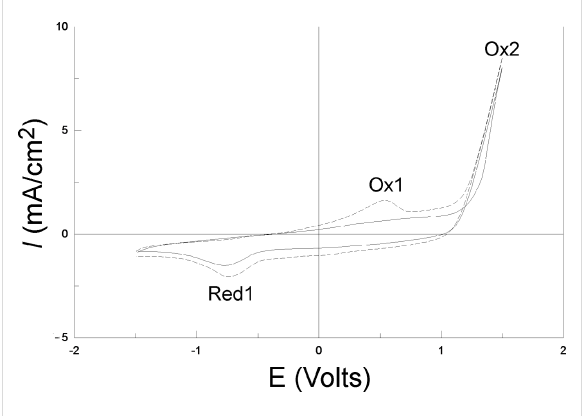
Figure 4: Two successive CVs performed on vitreous carbon with 10 mM EDOT and 0.1 M LiClO 4 in acetonitrile solution. Scan rate: 100 mV/s. The solid line corresponds to the 1st scan and the dashed line to the 2nd scan.